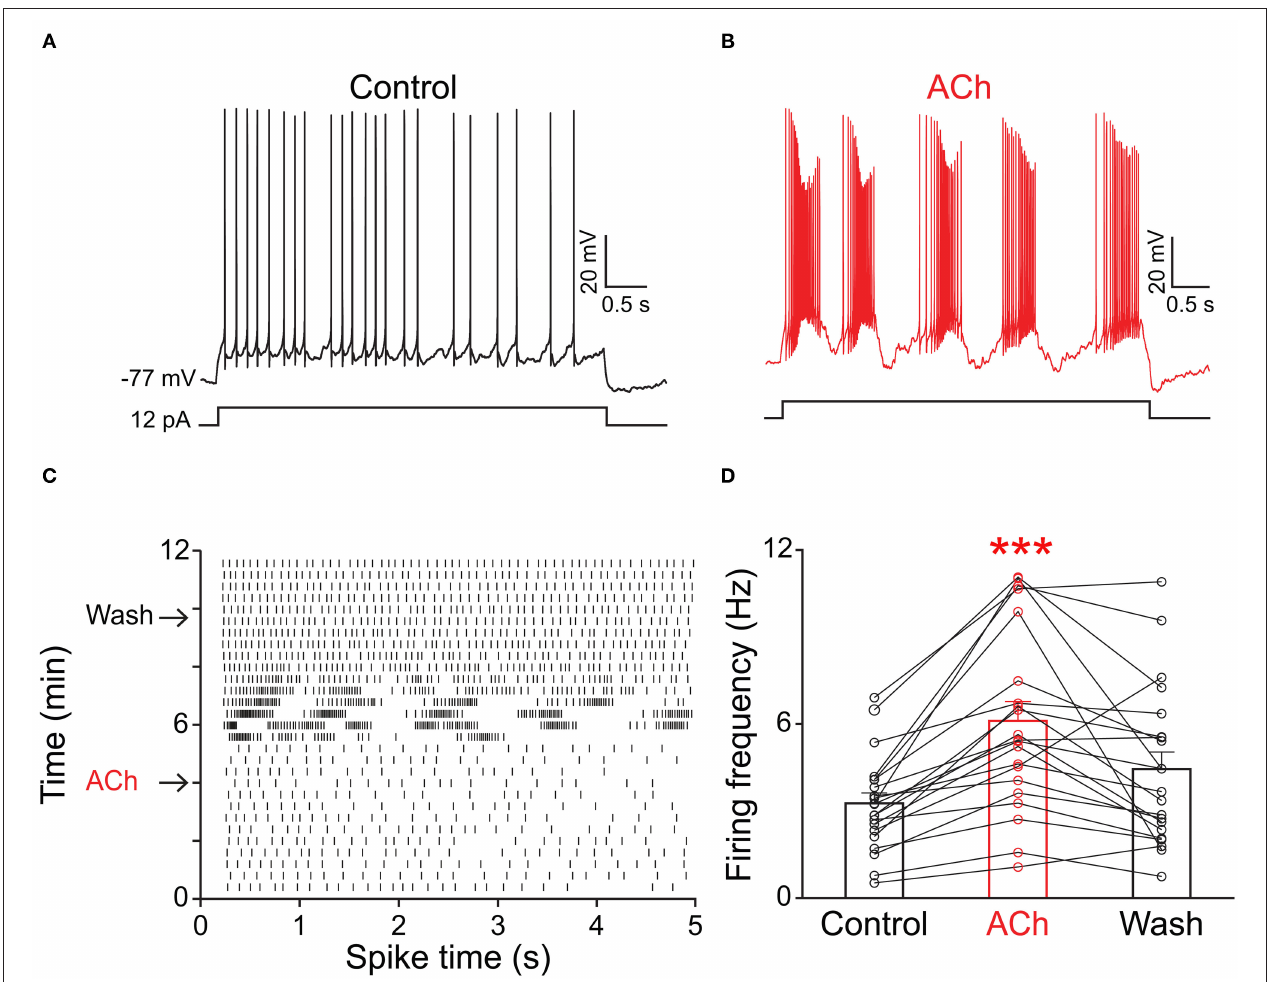
FIGURE 5 | PPG neurons were excited by acetylcholine (ACh). Representative current-clamp recording elicited by injecting a perithreshold current of 12pA with a pulse duration of 5s in 18s intervals. (A) A baseline recording of 5min was acquired before (B) switching to bath application of ACh for 5min, followed by a wash out. Note development of bursting activity with prominent spike adaptation within the burst. (C) Example raster plot of the cell in A-B indicating 5s pulse duration vs. time of recording period (12min). Arrows indicate the times when ACh was introduced or washed from the bath, respectively. (D) Bar/line graph of the mean spike frequency changes for 21 sampled PPG neurons under baseline, ACh, and wash conditions. ***Significantly-different from baseline, one-way RM ANOVA with Tukey’s post-hoc test, p <